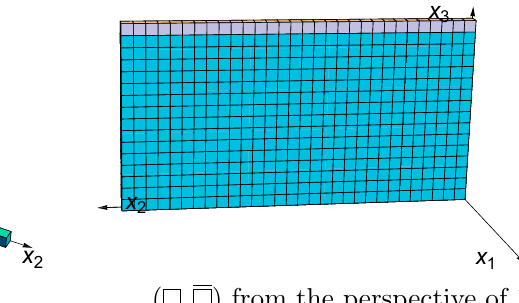
Figure 8 . The state